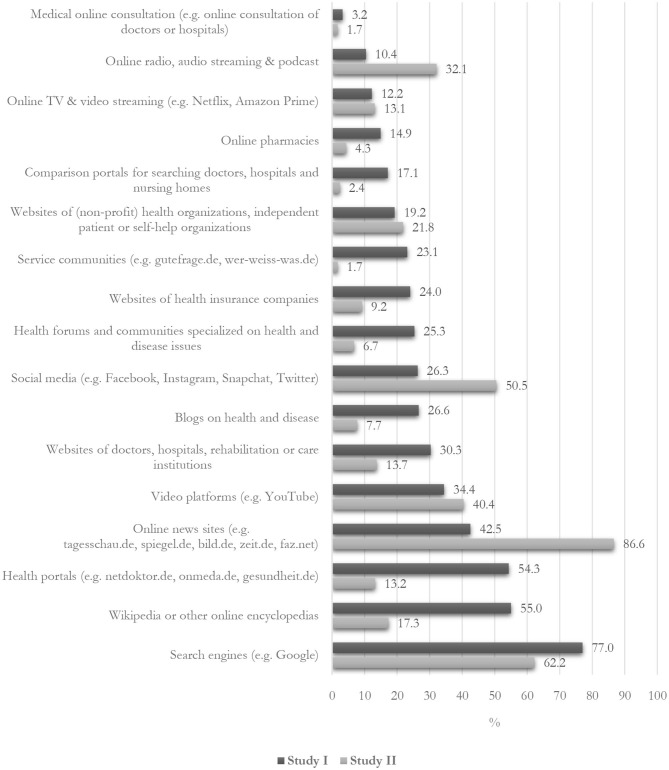
Online sources for information on health and disease (study I) and on coronavirus (study II), respectively. Percentage among participants. Study I: n = 3,920; Question: “Which online sources have you used in the past 12 months for information on health and diseases?”; study II: n = 2,735; Question: “Which online sources have you used to obtain information about the coronavirus?”; Pearson's chi-square: medical online consultation: χ2 = 14.20, p < 0.001; online radio, audio streaming, and podcast: χ2 = 484.99, p < 0.001; online TV and video streaming: χ2 = 1.02, p > 0.05; online pharmacies: χ2 = 191.92, p < 0.001; comparison portals: χ2 = 355.07, p < 0.001; websites of (non-profit) health organizations, independent patient or self-help organizations: χ2 = 6.51, p < 0.05; service communities: χ2 = 603.55, p < 0.001; websites of health insurance companies: χ2 = 238.89, p < 0.001; health forums and communities specialized on health and disease issues: χ2 = 384.15, p < 0.001; social media: χ2 = 405.95, p < 0.001; blogs on health and disease: χ2 = 376.12, p < 0.001; websites of doctors, hospitals, rehabilitation, or care institutions: χ2 = 244.40, p < 0.001; video platforms: χ2 = 24.91, p < 0.001; online news sites: χ2 = 1,314.98, p < 0.001; health portals: χ2 = 1,161.57, p < 0.001; Wikipedia or other online encyclopedias: χ2 = 955.23, p < 0.001; search engines: χ2 = 169.54, p < 0.001.